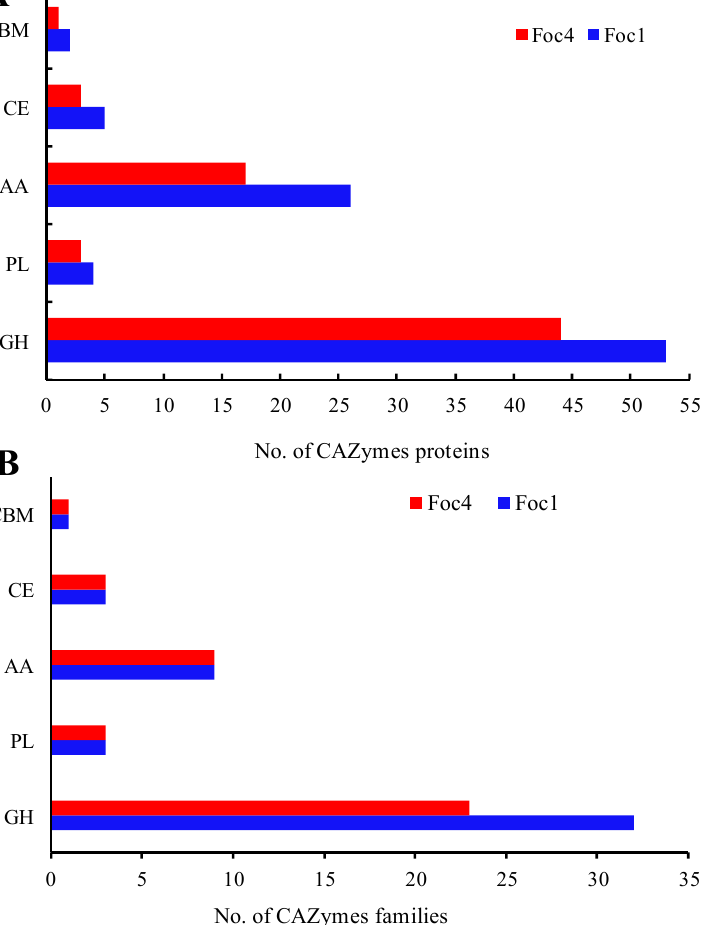
Figure 3. Comparison of CAZymes proteins ( A ) and CAZymes families ( B ) identified in Foc1 and Foc4 secretomes.